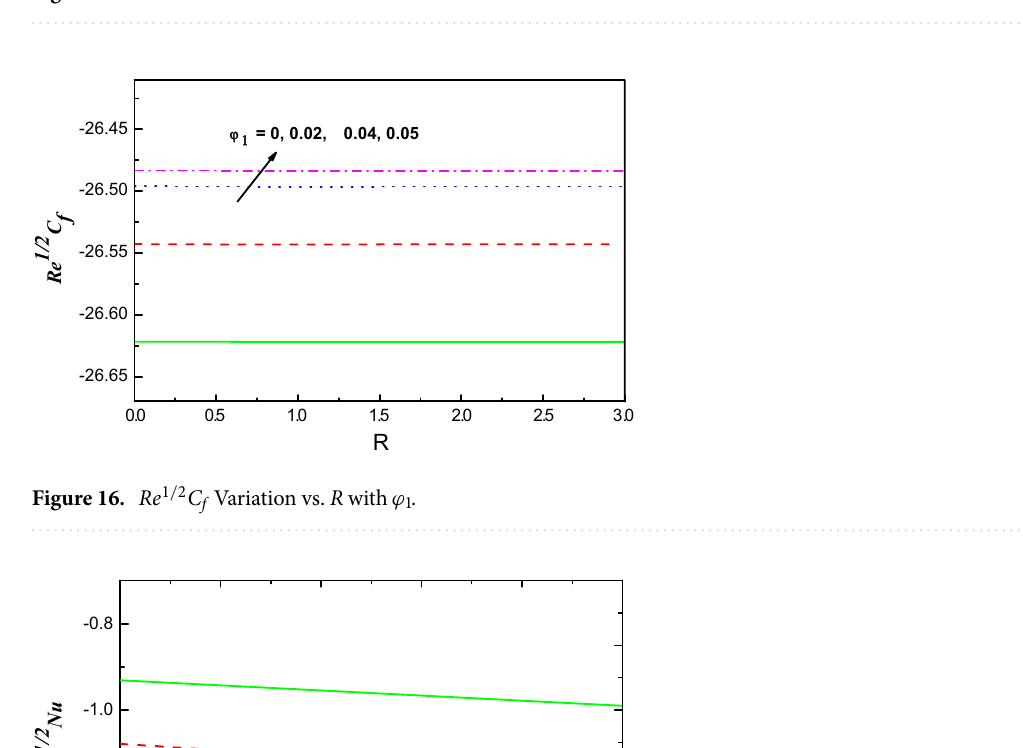
Figure 15. Re − 1 / 2 Nu Variation vs. K with Ec .